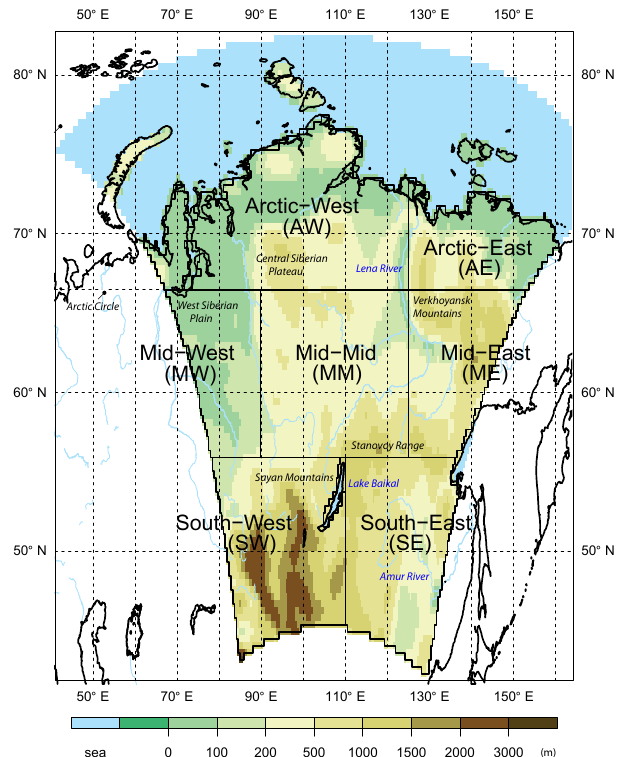
Fig. 1. Orography [m] of model domain of CCLM (colored area) for Siberia and considered subregions on a lat/lon